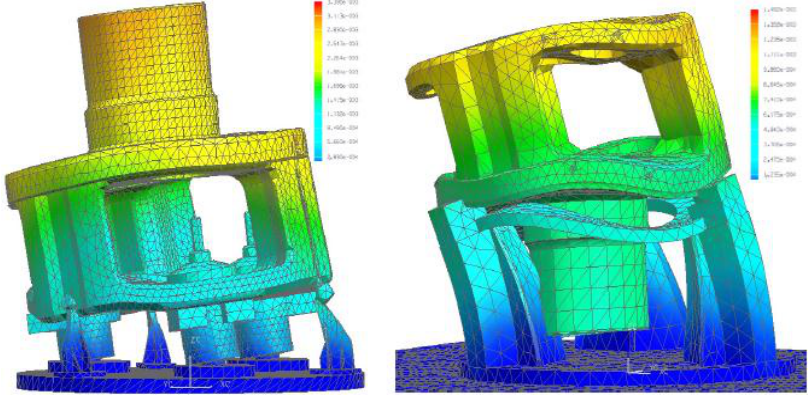
Figure 9. FEM model results for two fixture configurations.